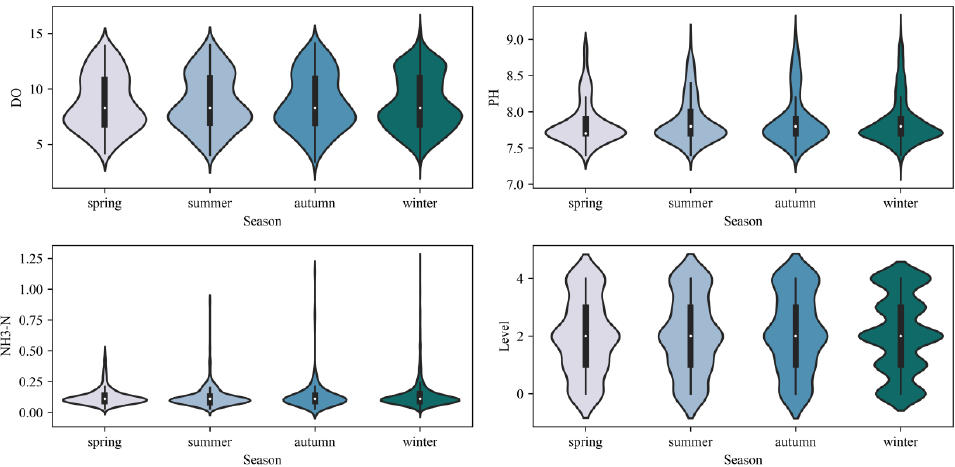
Figure 8. Distribution of water quality by season.